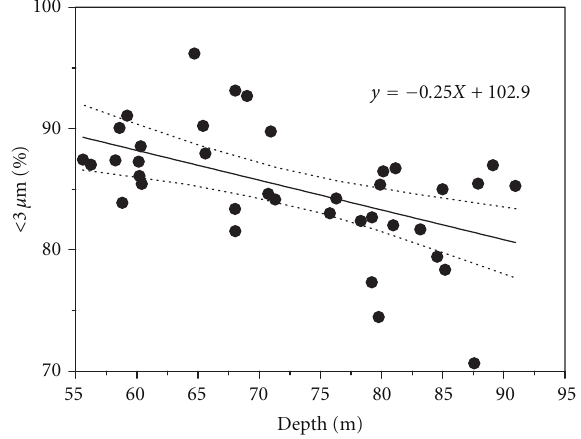
Figure 5: Contribution (%) of picocells fraction to total Chl a at the DCM as a function of the DCM depth. The solid line shows the significant relationship ( r = − 0 . 53, P < 0 . 01, n =